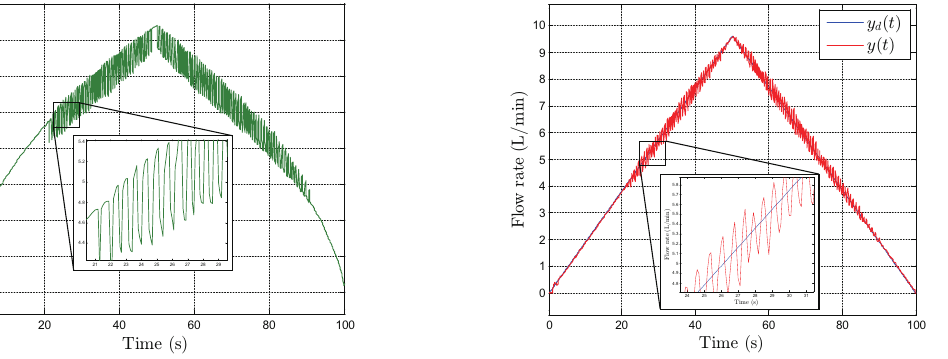
( b ) Response characteristics of the feedforward plus feedback control system integrated in cascade structure Figure 15. Experimental results of the feedforward plus feedback control system integrated in cascade